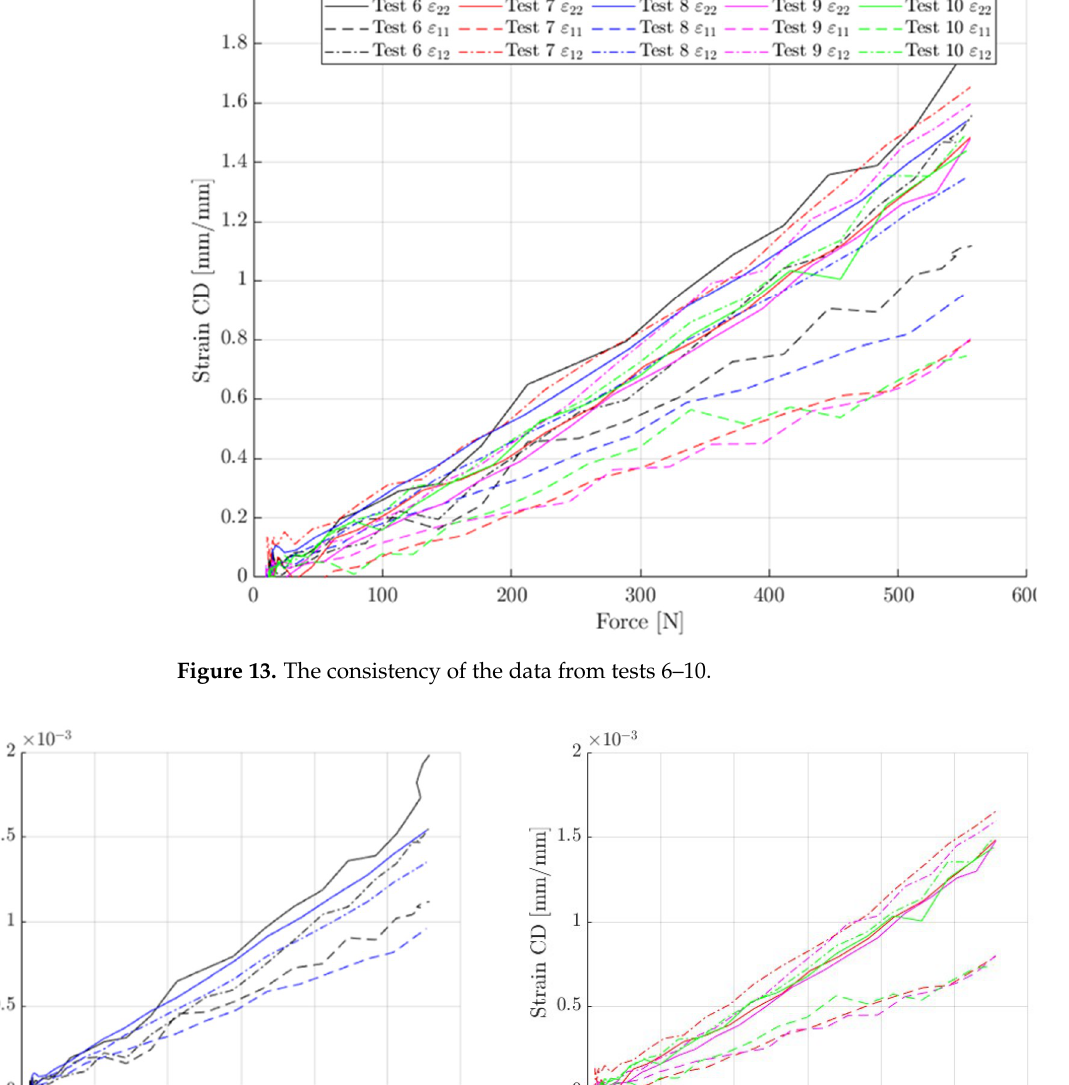
Figure 14. The consistency of data in tests 6–10: ( a ) group 1 (tests 6 and 8); ( b ) group 2 (tests 7, 9 and